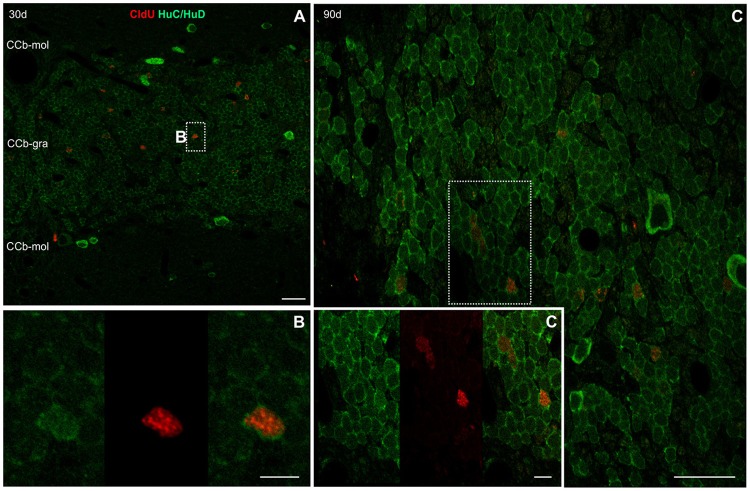
Neuronal differentiation in the corpus cerebelli at 30, 90, and, 180 days after four daily injections of CldU demonstrated by co-localization with HuC/HuD. (A) Low power microphotograph at the region of the corpus cerebelli. The dotted rectangle indicates location of a double labeled cell, as illustrated by the microphotographs of each channel and the overlay (B) in the inset in (A). (C) Higher power image of a stack of 25 confocal planes, every 0.5 μm. The rectangle indicates the location of a cell which co-localization was demonstrated by the x-z and y-z orthogonal projections of the same stack (C') as well as each channel and overlay of a single plane (C″). Scale bars: (A) 20 μm; (B, Inset in A) 100 μm; (B,C”) 5 μm.